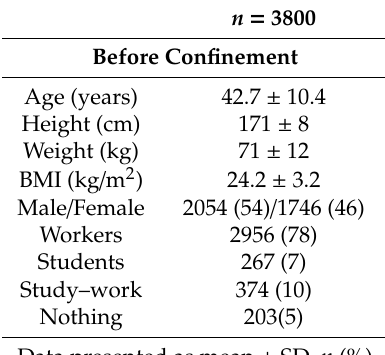
Table 1. Demographic characteristics of 3800 healthy subjects before